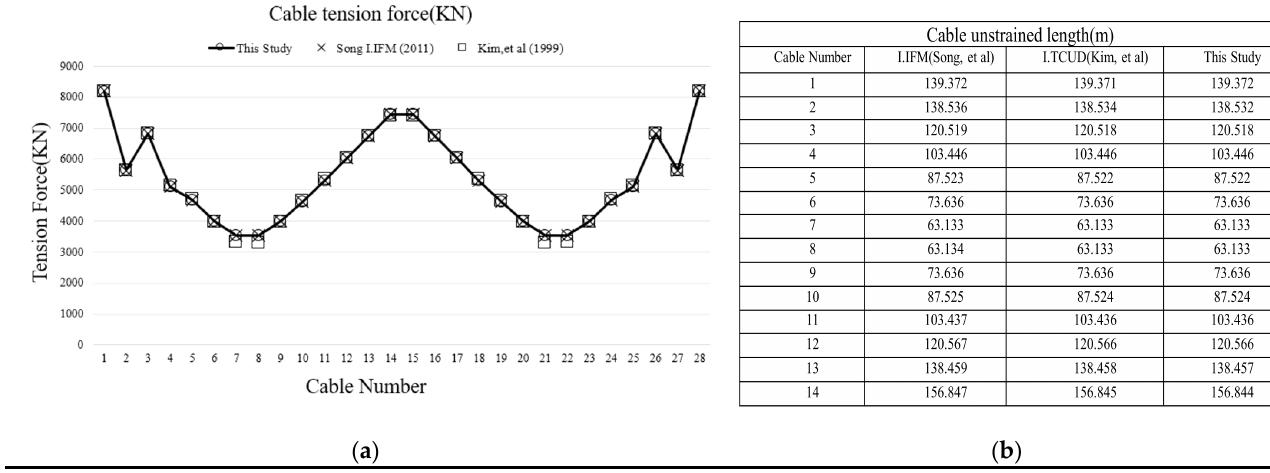
Figure 15. Cable forces and unstrained length in initial state of a cable-stayed bridge: ( a ) Cable tension force; ( b ) Cable unstrained